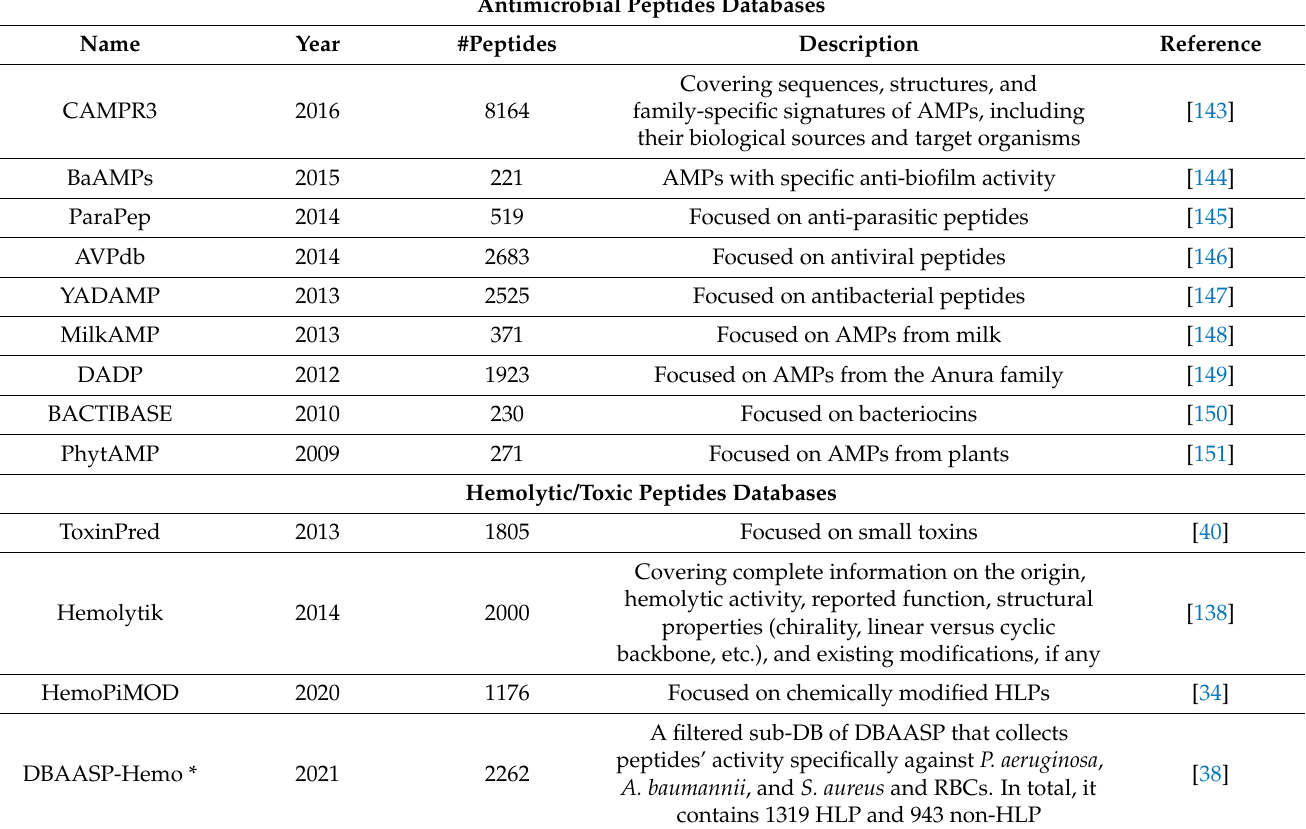
Table 2. Cont. Antimicrobial Peptides